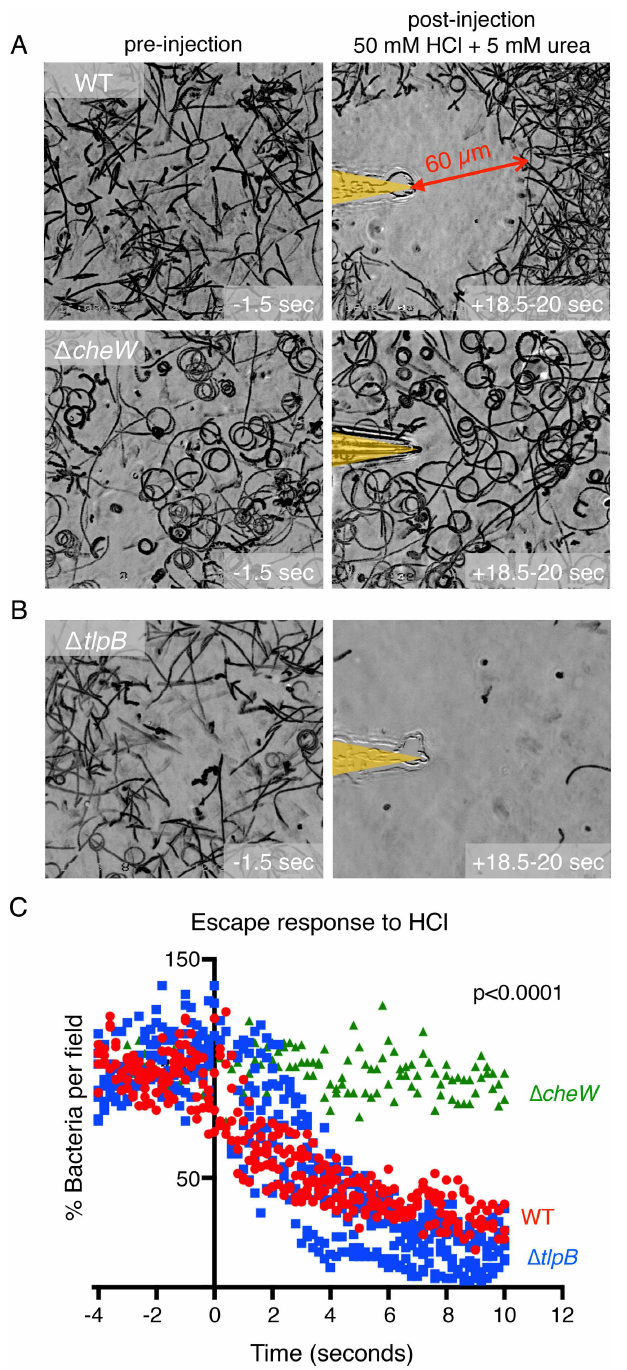
Fig 1. H . pylori simultaneously responds to chemoattractants and repellents and does not require TlpB to swim away from an acid gradient. ( A ) Still images of bacterial motility traces (lasting1.5 seconds) of PMSS1 wild-type(WT) H . pylori and Δ cheW H . pylori within the field of view 1.5 secondsbefore and 18.5 seconds after exposure to a combinedgradientof 5 mM urea and 50 mM hydrochloricacid. The positionof the microinjection needletip is highlightedin yellow. ( B ) Still images of bacterial motility traces (lasting1.5 seconds) of Δ tlpB H . pylori within the field of view 1.5 secondsbefore and 18.5 seconds after exposureto a gradientof 5 mM urea and 50 mM hydrochloric acid. ( C ) Quantification of the responses of WT H . pylori vs. Δ tlpB vs Δ cheW to a 100 mM hydrochloricacid gradient. Each point represents the percent of swimming